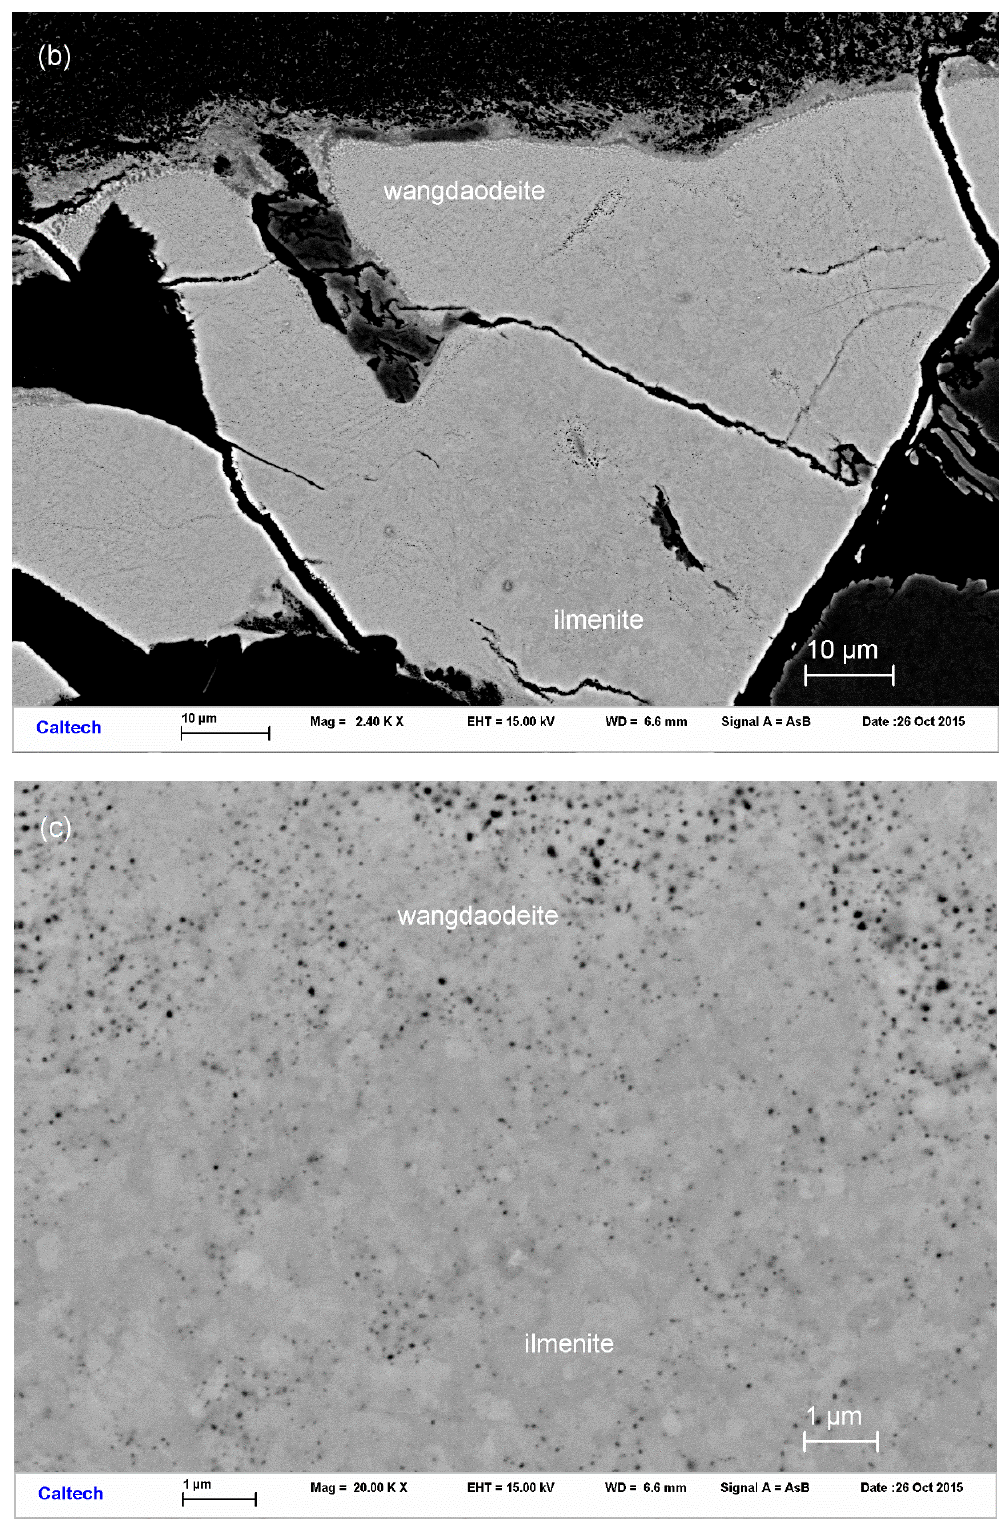
Figure 1. ( a ) SEM BSE image showing part of a wangdaodeite-bearing shock melt vein in Ries section ZLN114c; ( b ) enlarged BSE image of wangdaodeite and recrystallized ilmenite in contact with the shock melt vein; ( c ) a further enlarged BSE image showing individual crystallites of wangdaodeite and recrystallized ilmenite. The two minerals have the same composition within the resolution of the EPM analysis.